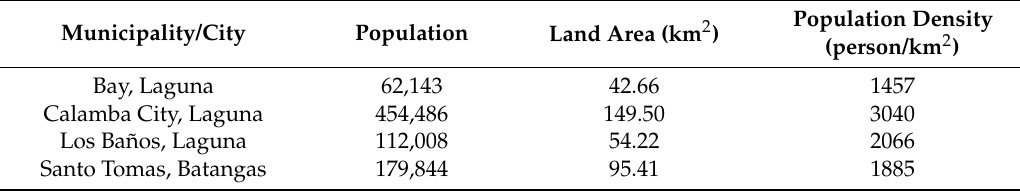
Table 1. Population, Land Area and Population Density of Areas portions of which are covered by the Mount Makiling Forest Reserve [34].